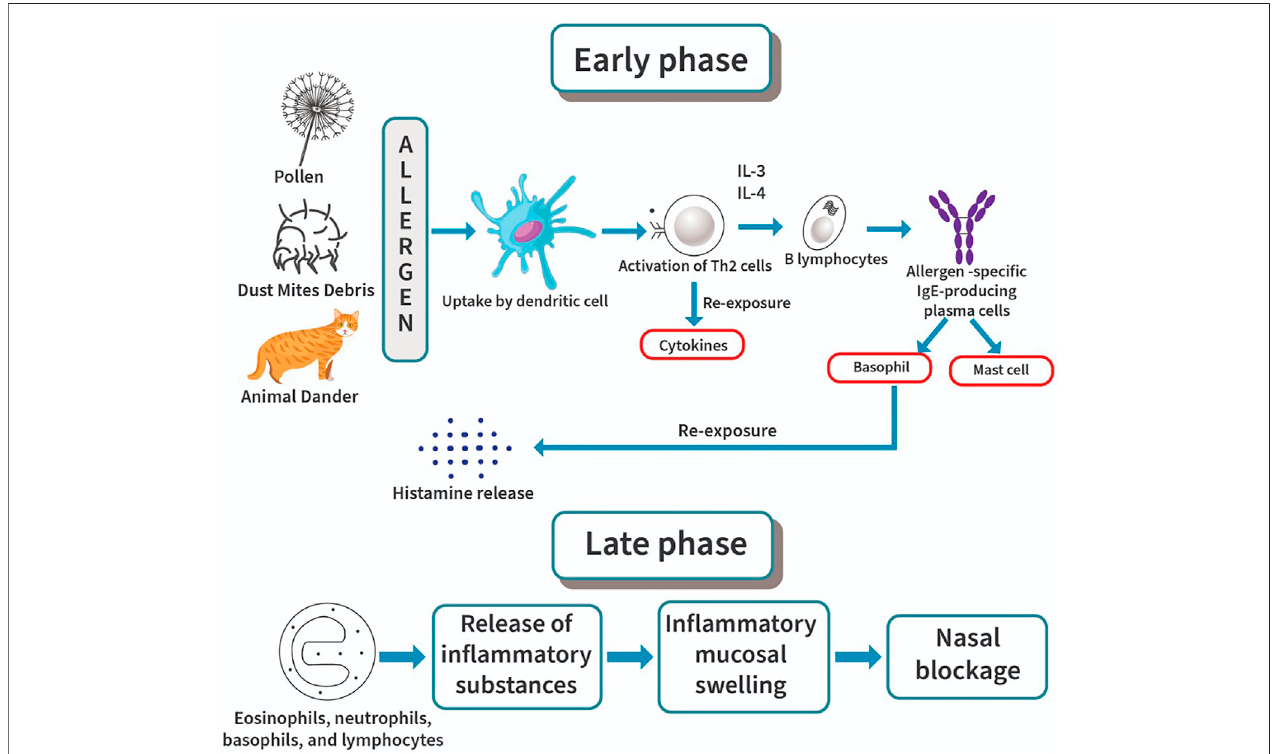
FIGURE 1 | Pathophysiology of allergic rhinitis: early phase and late